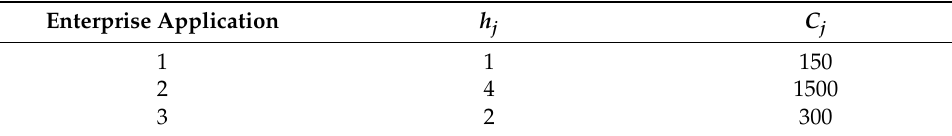
Table 3. Enterprise application parameters.